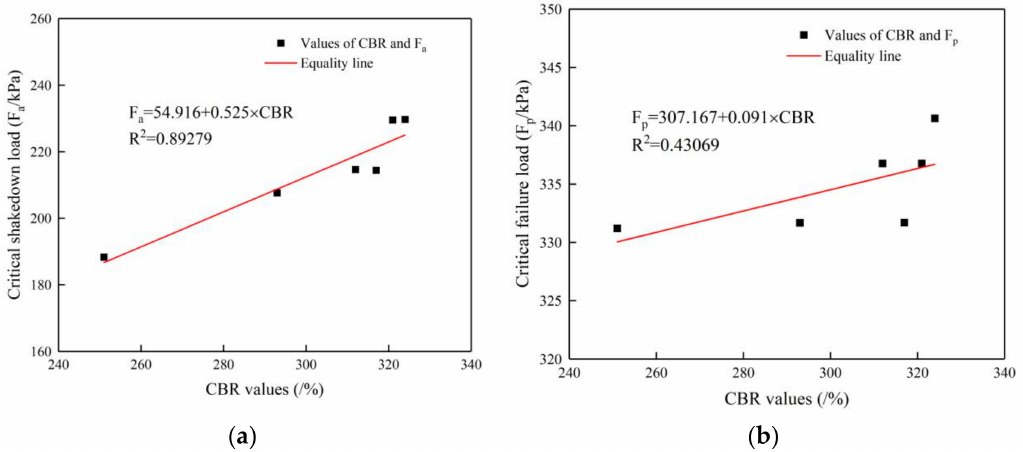
Figure 18. ( a ) Relationship between CBR values and critical shakedown load; ( b ) relationship between CBR values and critical failure